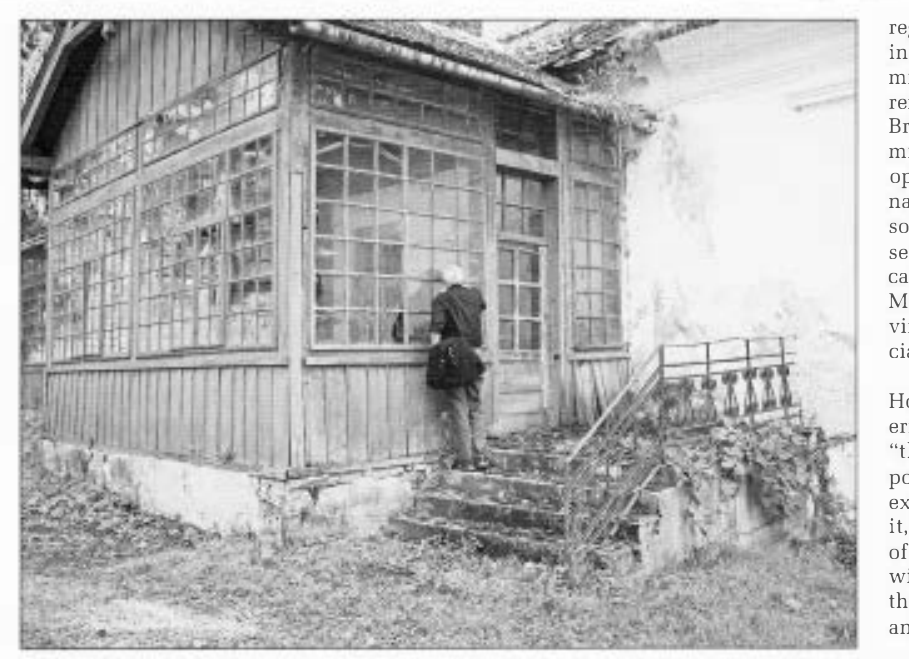
Figure 4 (above and right) Rosia Mon­ tana goldmining museum, Romania. The museum and machinery have been aban­ doned and a huge opencast mining oper­ ation threatens to obliterate all, including the Roman goldmine on the